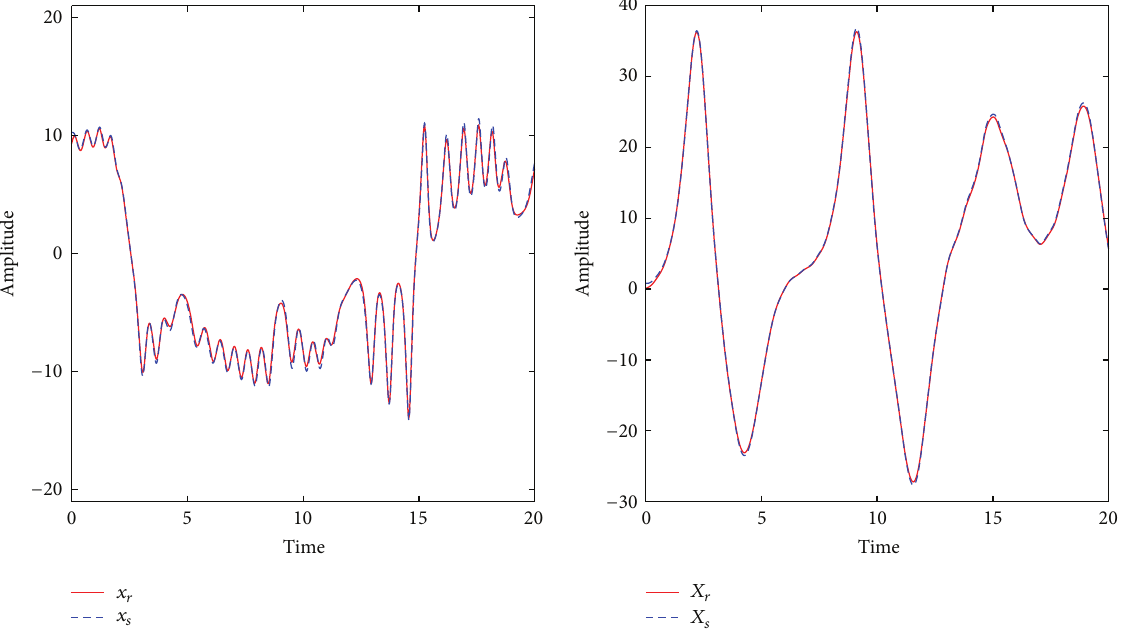
Figure 13: Original trajectory (in red) and pseudoorbit (in blue) for fast 𝑥 and slow 𝑋 variables for 𝑐 0 = 0.8 . be resolved by introducing a time-dilation variable 𝜇